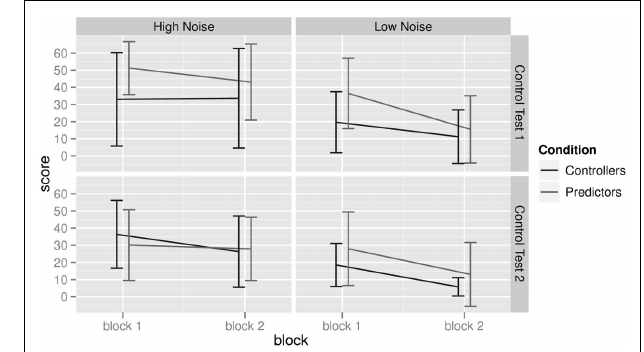
FIGURE 3 | Control error scores ( ± SE) of predictors and controllers in the test phase of Experiment 1.